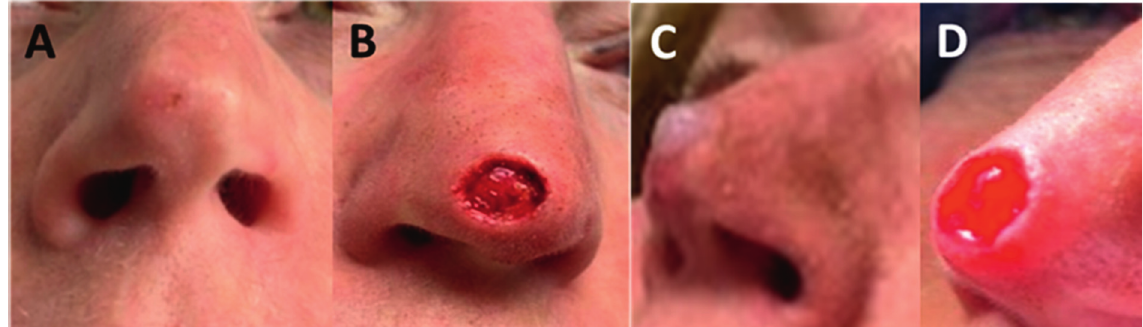
Figure 3: The patient underwent MMS down to the perichondrium on 2/27/2020 ((a) before and (b) immediately after MMS). UC was immediately applied (c), and then, a new piece of UC allograft with nonadherent dressing was applied weekly for the following three weeks with minimal debridement. Prolific granulation tissue was formed by one week, on 3/5/2020 (d).